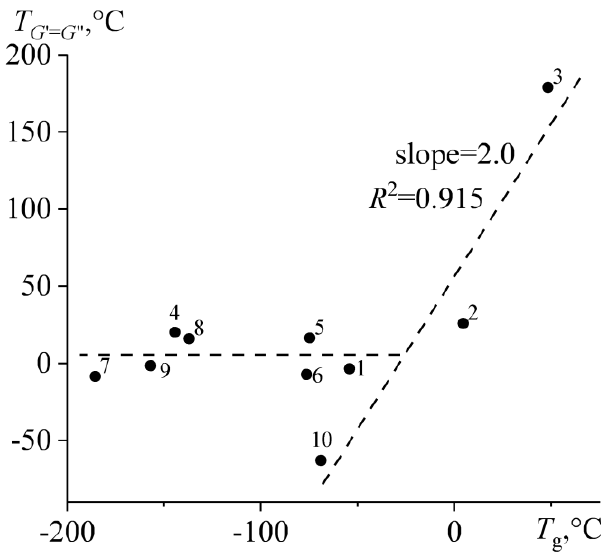
Figure 15. Correlation between the nominal solid–liquid transition temperature and the rheometric glass transition temperature. Bitumen numbers are located near experimental points.